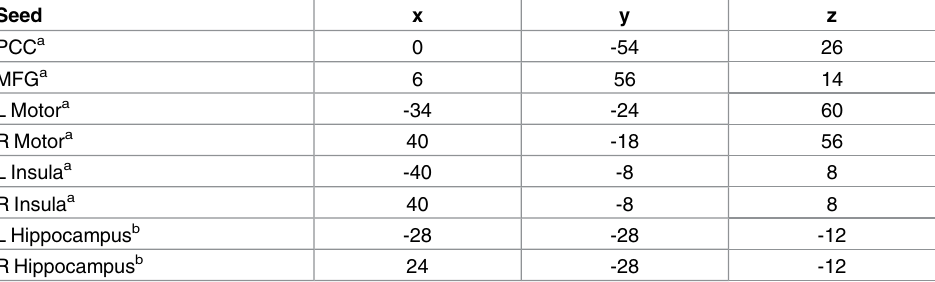
Table 1. Montreal Neurological Institute coordinates of seed regions used in the functional connectiv- ity analysis. Seed